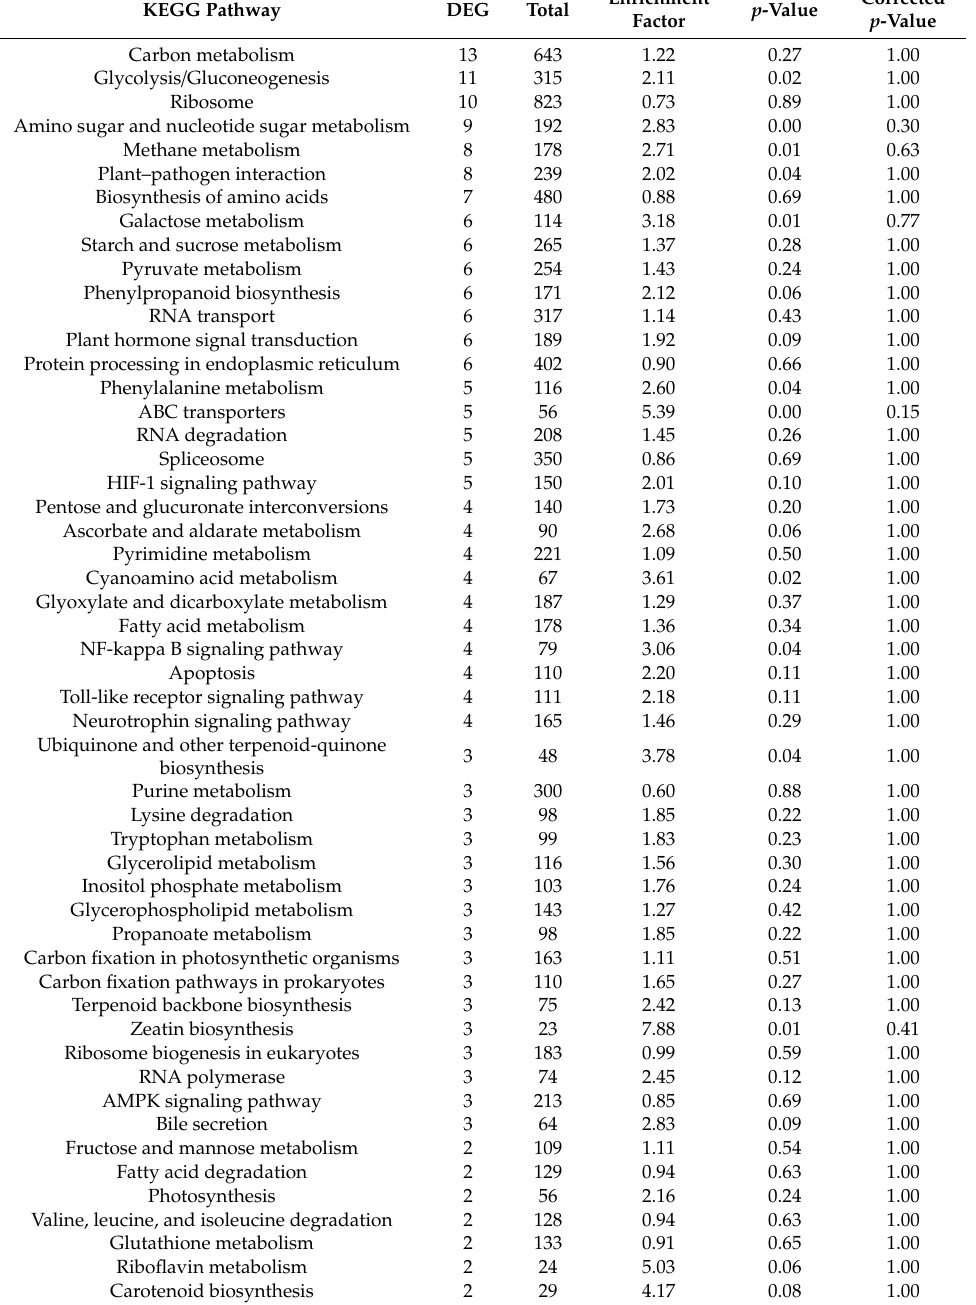
Table 3. Di ff erentially expressed unigenes with significantly enriched